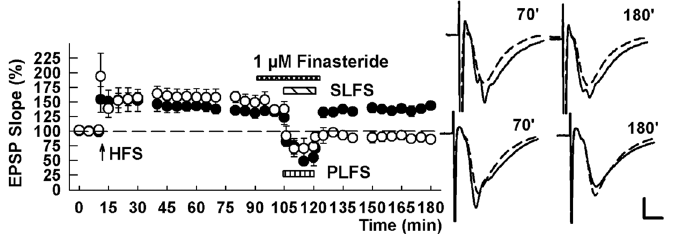
a separate set of slices (white circles). HFS was administered to the SC pathway at the arrow. Traces show representative EPSPs at the times indicated. Calibration bar: 1 mV, 5